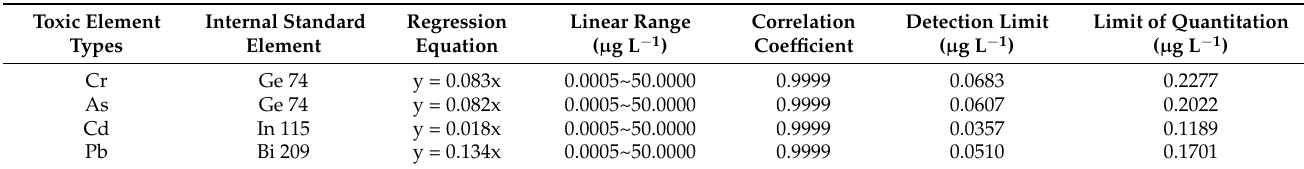
Table 1. Results of methodological verification of toxic elements in chicken.